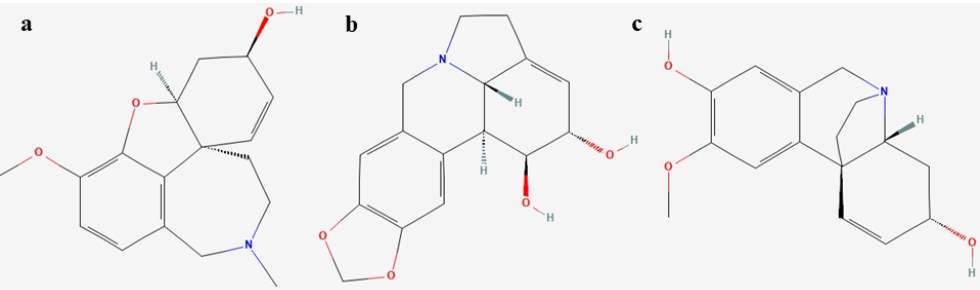
Figure 4. Chemical structure of Amaryllidaceae alkaloids isolated in L. aestivum in vitro plants ( a ) galanthamine, ( b ) lycorine, ( c ) demethylmaritidine.